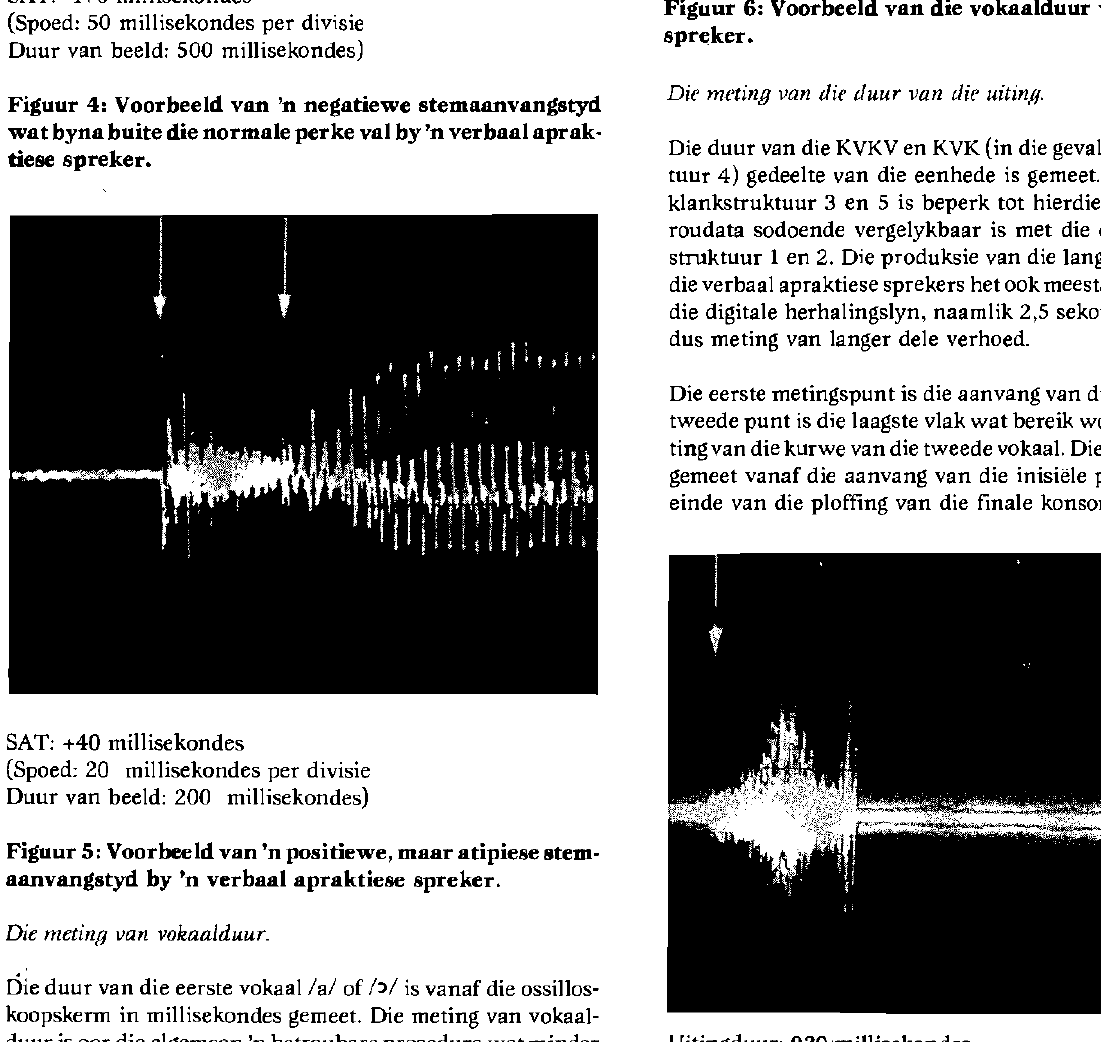
Figuur 7: Voorbeeld van die uitingduur van 'n verbaal apraktiese